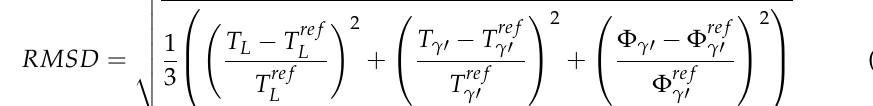
→ c are cracking sensitivity,